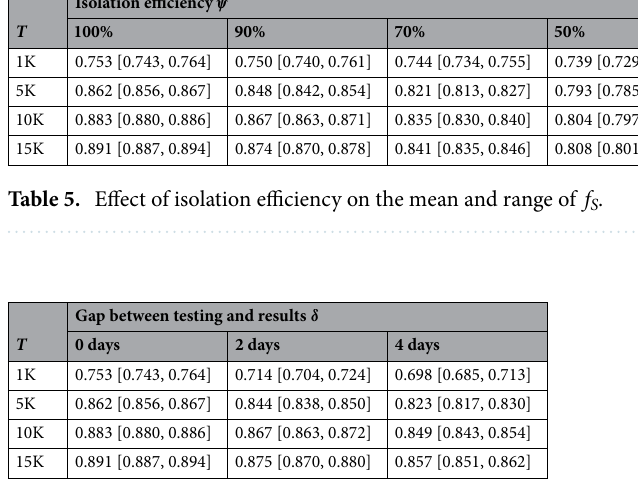
Table 6. Impact of gap δ between testing and availability of test results on the mean and range of f S .